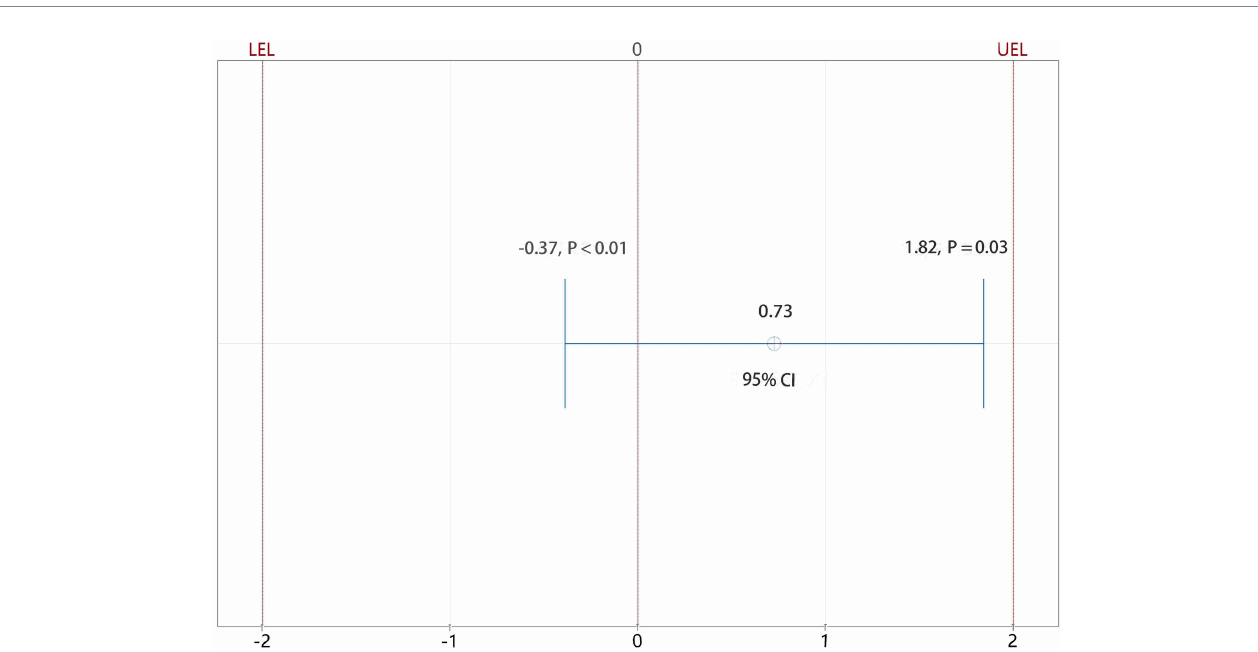
FIGURE 5 Equivalent test results of iliopsoas muscle space group and posterior lumbar plexus group. CI: confidence interval; LEL: lower equivalence limit; UEL: upper equivalence limit. Using the non-parametric TOST, the CI fell within the predetermined range of − 2.0 to 2.0, the effects of the two therapies on postoperative pain were